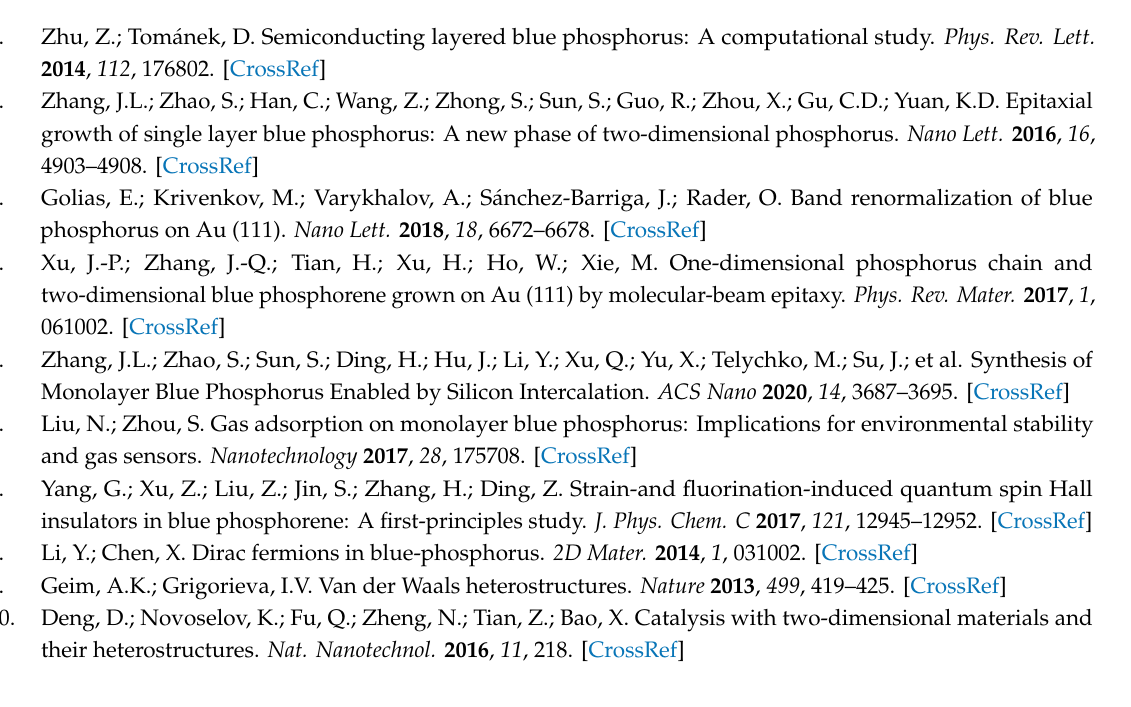
Figure S1: Change in di ff erential phase with respect to the variation in local refractive index of sensing interface by modulating the numbers of BlueP interlayer and the thickness of Au film: (a) 40 nm, and (b) 45 nm, respectively. Table S1: The obtained phase detection sensitivity by slightly varying the SPR angle in an increment of ± 0.01 degree. Author Contributions: Y.Y. and X.P. conceived the ideal and supervised the project; K.L., L.L., and N.X. performed the simulations and drew the figures; Y.Z., J.S., and J.Q. analyzed the simulation data; Y.Y. wrote and revised